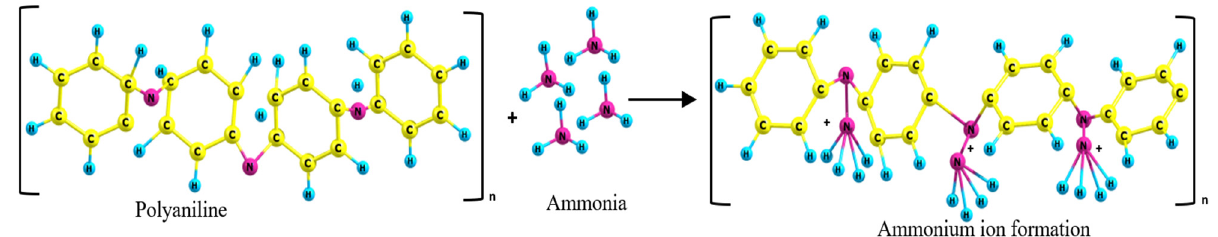
Figure 6. Schematic diagram of polyaniline-ammonia interaction. Table 2. Adsorption capacity of NH 3 over PANI and PANC at different inlet gas concentrations. Concentration, ( ppm )